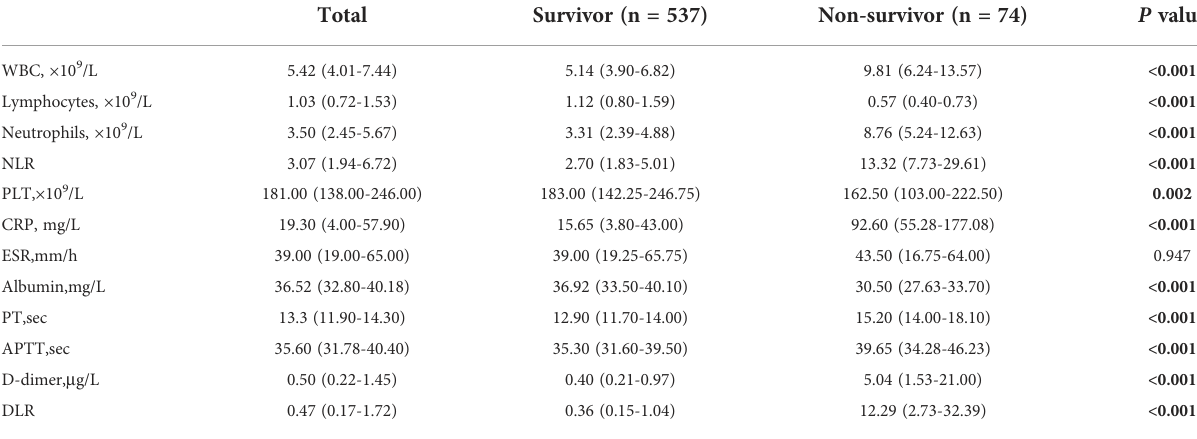
TABLE 2 Laboratory fi ndings between the survivor and non-survivor of COVID-19